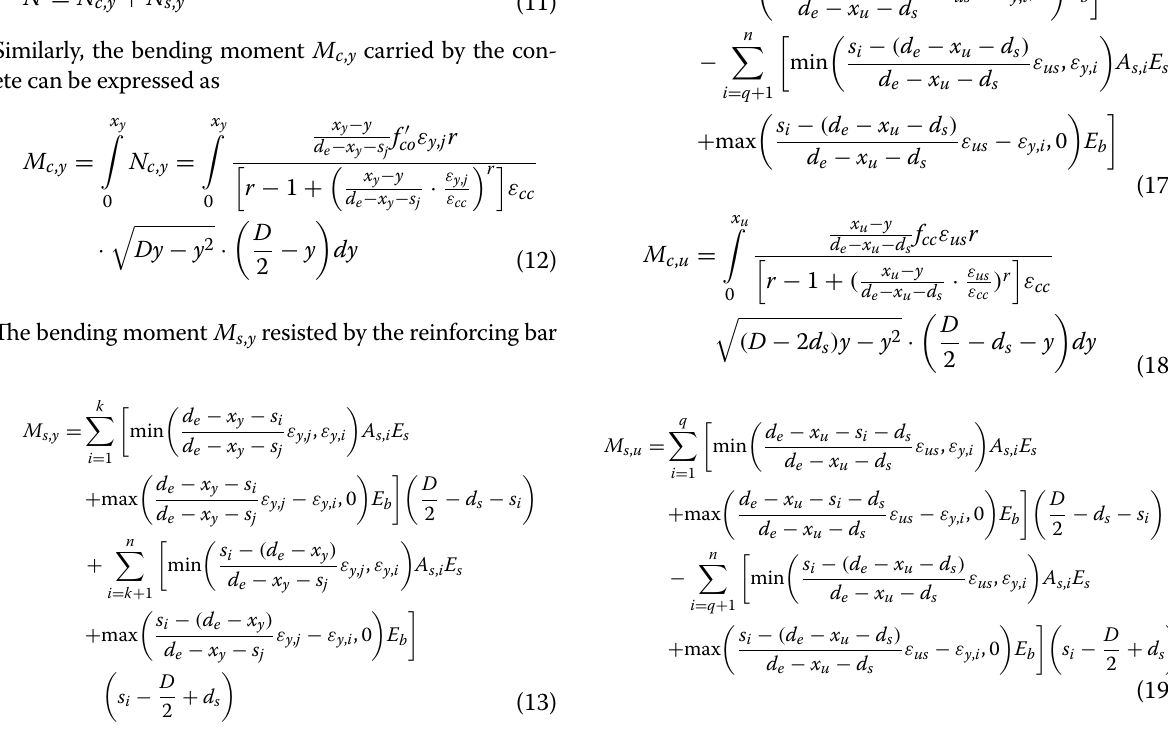
where A s , i is the area of the reinforcing bar in the i - th layer. When the axial load ( N ) is given, the neutral axis can be estimated from the following equilibrium equation.